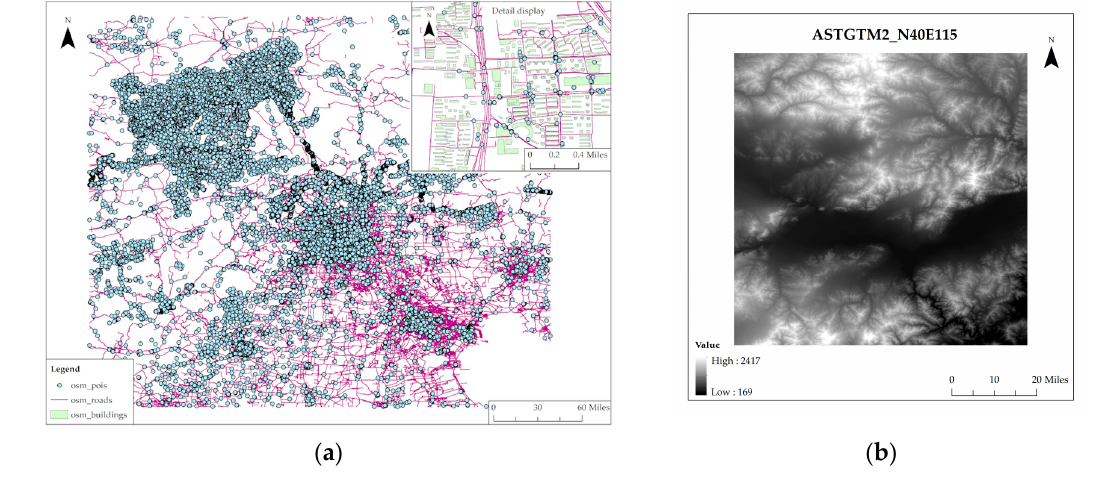
Figure 4. Testing Data: (a) Vector type; (b) Raster type.